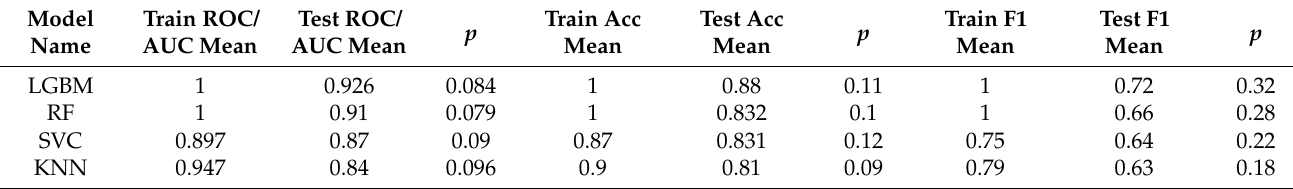
Table 7. The performance of four predictive models using the combined features.